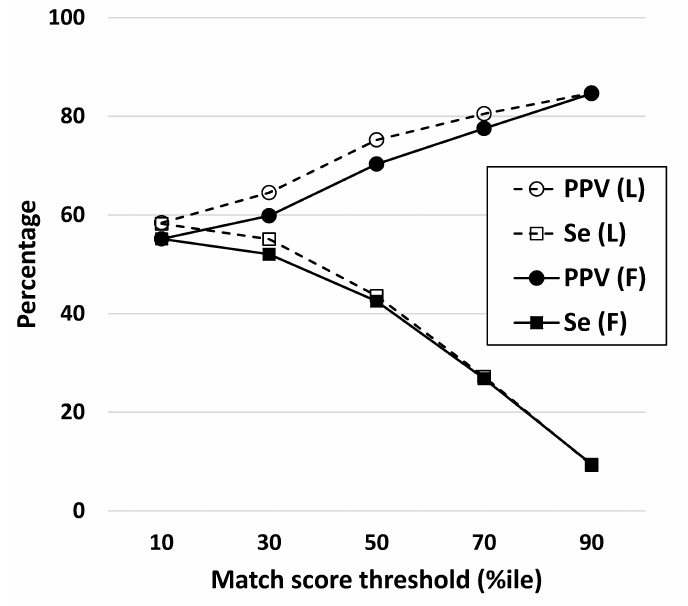
Supplemental Figure 3: Sensitivity (Se) and positive predictive value (PPV) of automated retrospective record linkage at various match score percentile thresholds, full (F) vs. limited (L)